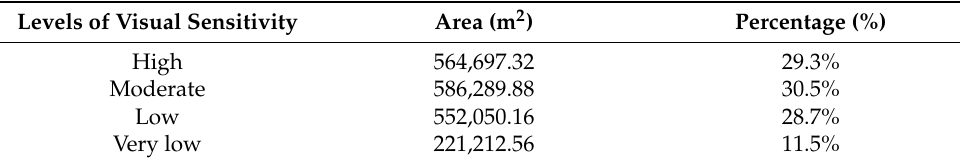
Figure 9. The visual sensitivity of the Wudadao historic district: ( a ) plan view; ( b ) 3D rendering. Table 2. Classification of landscape visual sensitivity composite index.